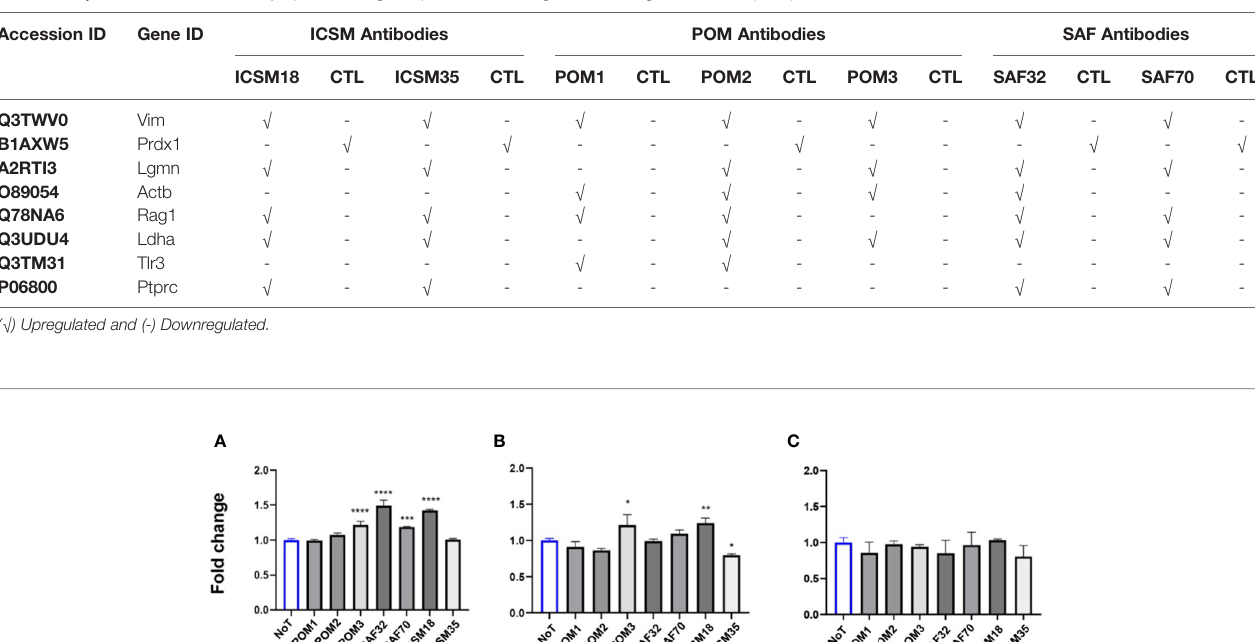
TABLE 10 | Identi fi cation of antibody-speci fi c allergenic proteins following direct microglia treatment (DMT).